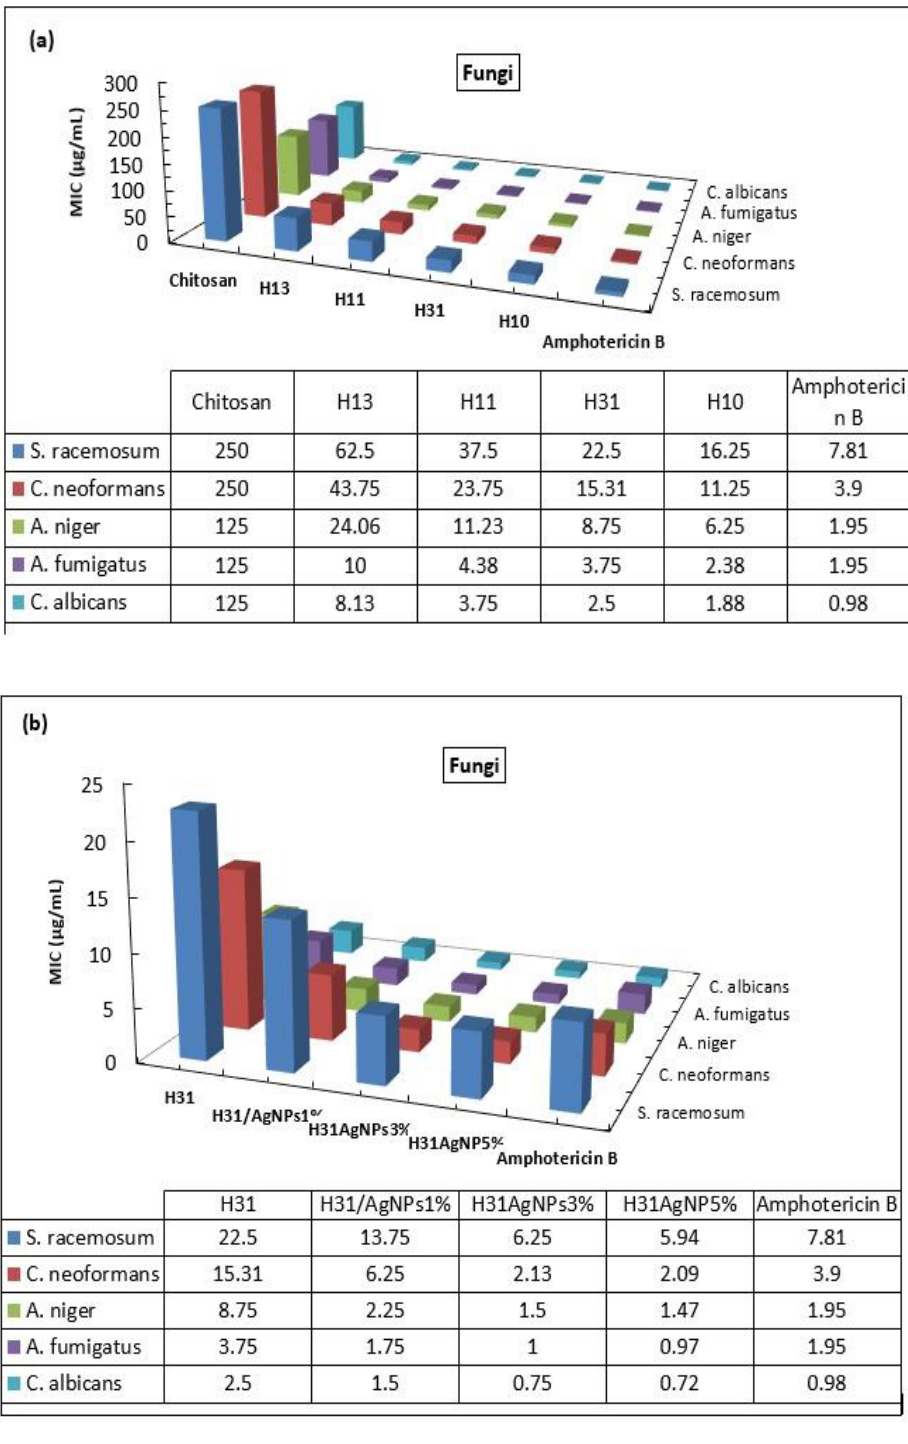
Figure 11. MIC values of: ( a ) hydrogels and ( b ) AgNP composites against the tested fungi. The insertion of AgNPs into the matrix of H 31 considerably improved its efficiency in inhibiting the activity of all the examined fungal strains, as illustrated by the MIC values (Figure 11b). H 31 /AgNPs1%, H 31 /AgNPs3%, and H 31 /AgNPs5% showed MIC values cans > A. fumigatus > A. niger > C. neoformans > S. racemosum . This indicates that the cell